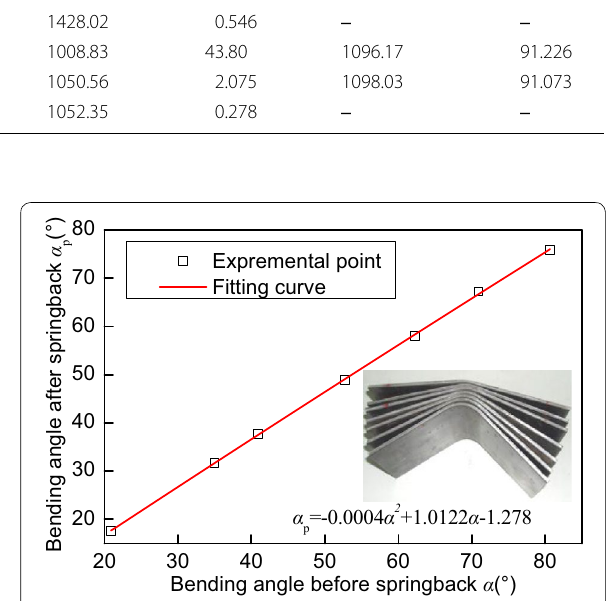
Figure 9 Bending angles of bending parts in V-free bending